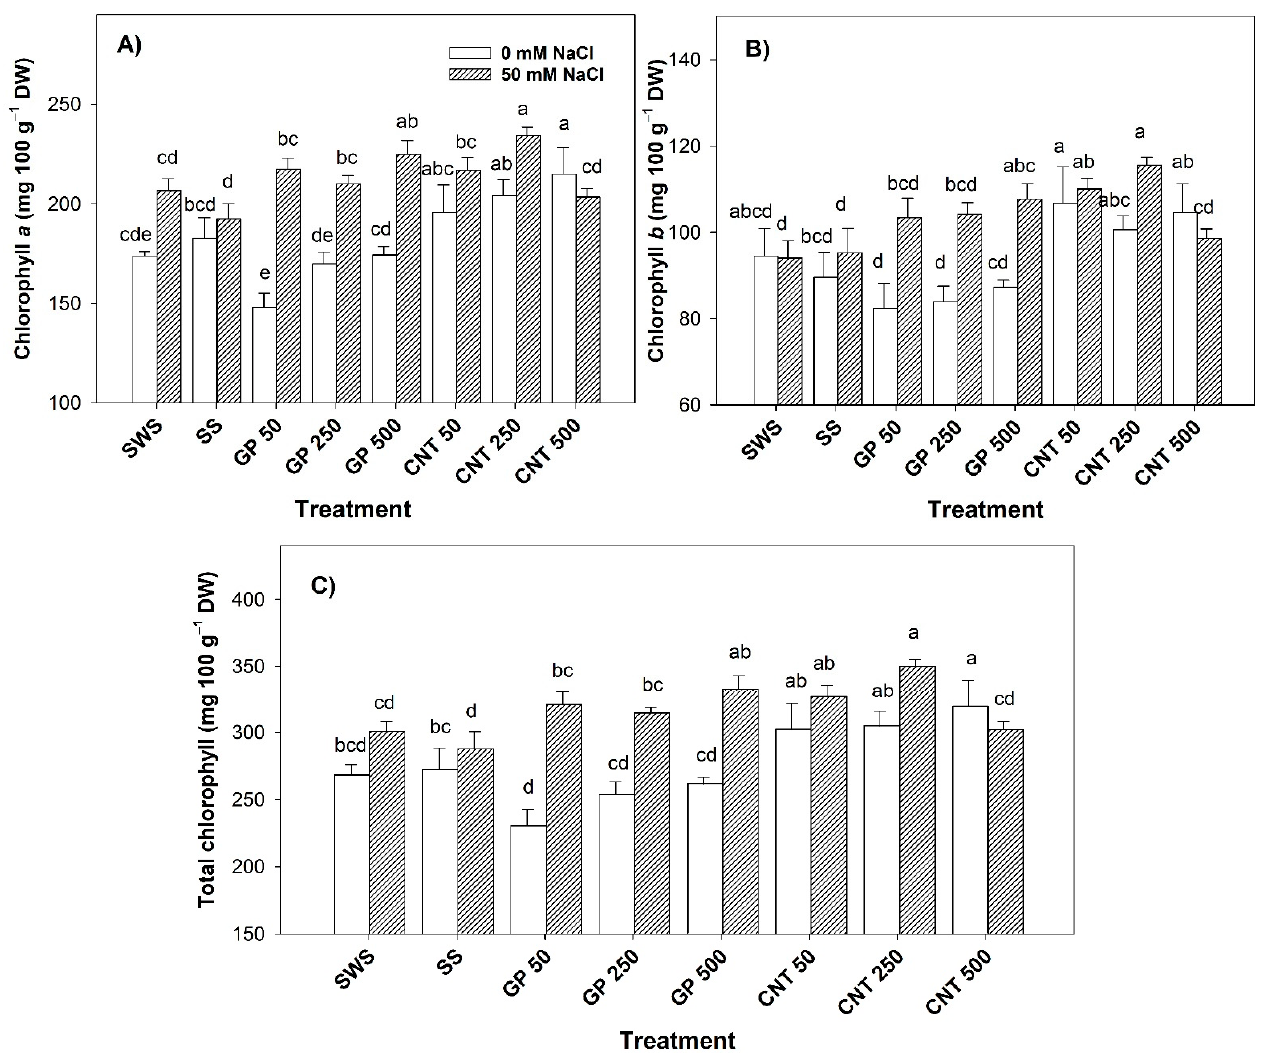
Figure 1. Photosynthetic pigments of tomato leaves treated with carbon nanomaterials and salinity: ( A ) chlorophyll a , ( B ): chlorophyll b , and ( C ) total chlorophyll. DW: dry weight; SWS: non-sonicated seeds; SS: sonicated seeds; GP: graphene; CNT: carbon nanotubes; 50, 250, and 500 represent the mg L − 1 applied of carbon nanomaterial. Different letters indicate a significant difference between treatments according to Fisher ( α = 0.05). n = 6 ± standard error.